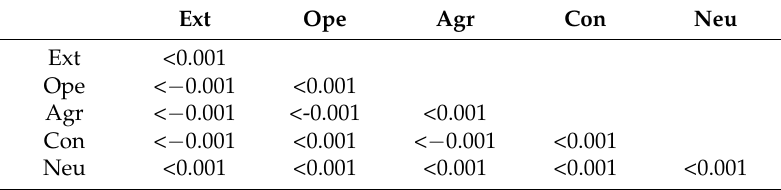
Table A2. Covariance Matrix of observed Five Factor Models ( n =